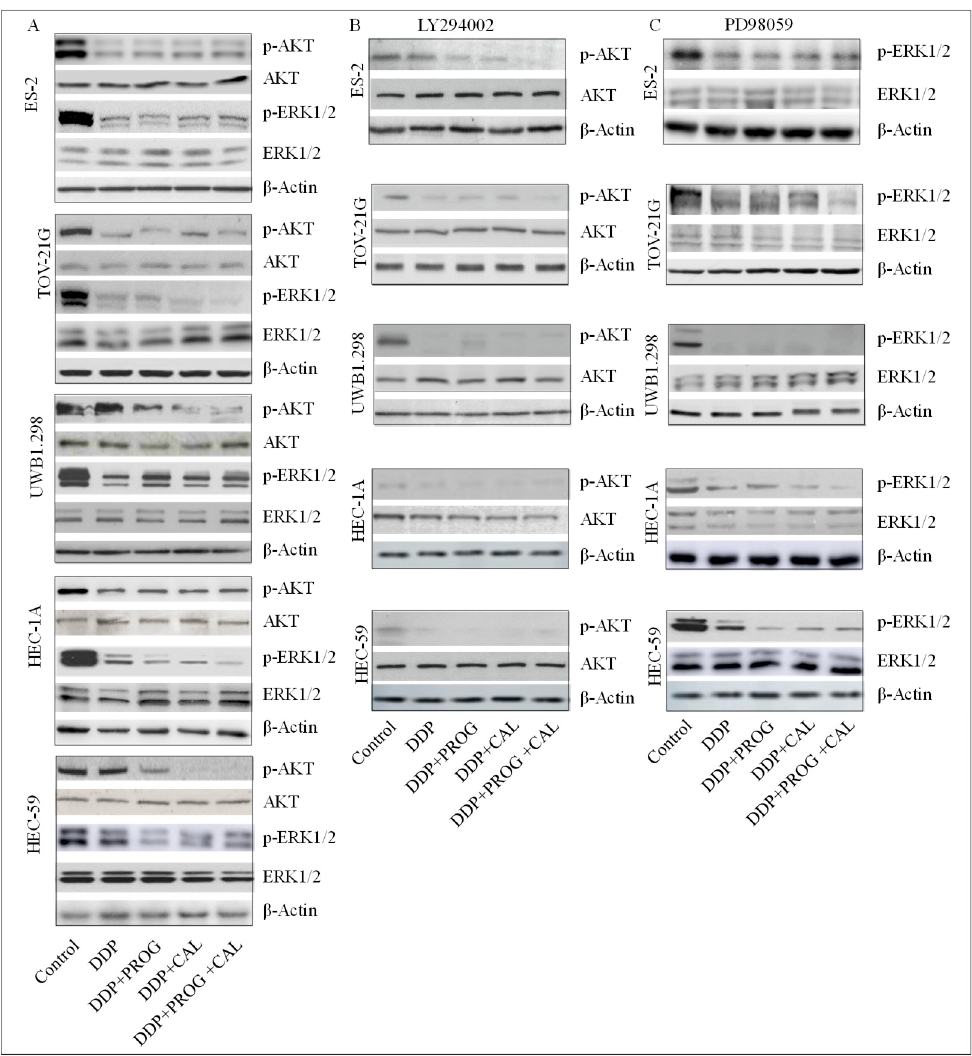
Figure 4. Progesterone-calcitriol combination enhanced the inhibitory e ff ect of DDP by attenuating the expression of pAKT and pERK1 / 2 in cancer cells. The ovarian and endometrial cancer cells were treated with DDP (6 µ M) and either with progesterone (20 µ M), calcitriol (30 nM), or the combination of the two in the presence or absence of PI3K / Akt pathway (LY294002, 50 µ M, B ), MEK / ERK pathway (PD98059, 10 µ M, C ) inhibitors for 76 h. Lysates from treated and control ( A ) cells were subjected to Western blotting for the assessment of survival pathway proteins. β -actin was used as a loading control. The values above the bands represent the relative density of the bands normalized to β -actin.